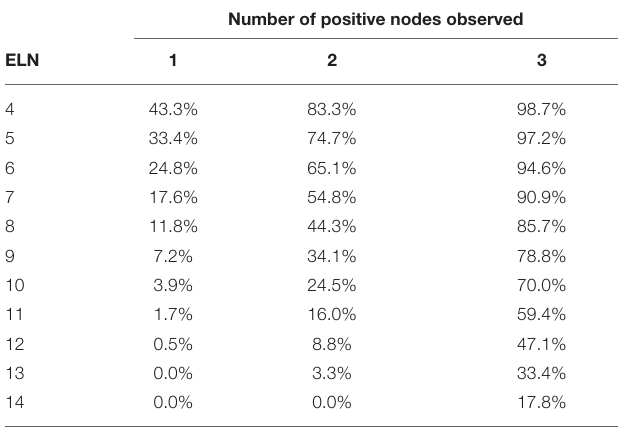
TABLE 7 | Probability of 4 or more positive lymph nodes in patients with T3